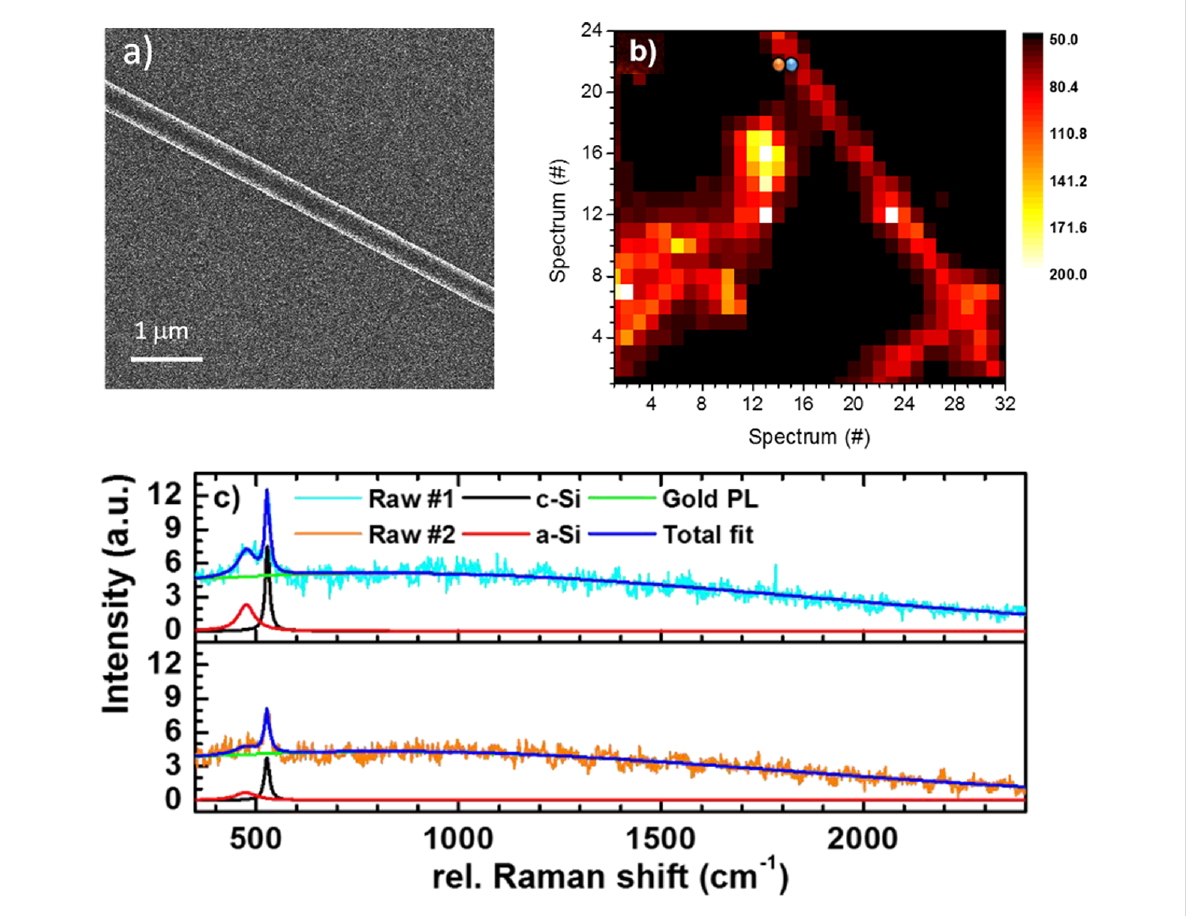
Figure 2: a) Representative helium ion microscopy image of a SiNW, which is supported on a Au-coated Si wafer. b) Hyperspectral image of the sam- ple surface. 32 × 24 spectra are taken from a 20 × 20 µm 2 area. The color scale is based on the integrated intensity of each taken spectrum. c) Two example spectra taken from the positions marked by the orange and the blue dot in panel b. The original data is plotted in light-blue and orange. The Raman peaks of crystalline and amorphous silicon are fitted using Lorentzian functions, which are indicated by the black and the red line, respective- ly. The total fit for both spectra is indicated by the dark-blue line. Furthermore, the spectral background is fitted (green line) using a Gaussian function. The background results from photoluminescence of the Au film. Excitation source: 636.3 nm continuous-wave diode laser.